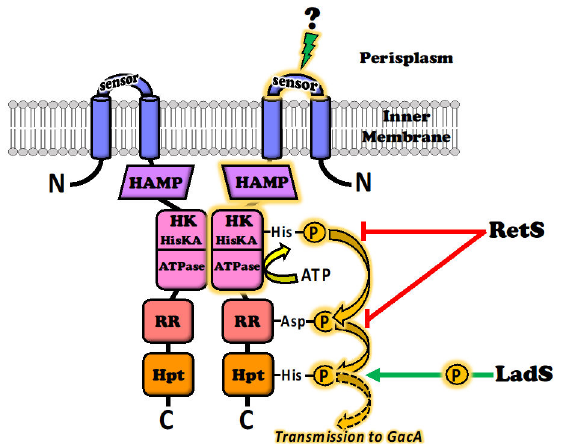
Figure 1. Architecture and functioning of the GacS sensor kinase. GacS is capable of collecting a pool of membrane stimuli: the central environmental source signal (still unknown) is perceived by the periplasmic sensor domain and causes a conformational change that is mechanically transmitted by the HAMP domain to the histidine kinase (HK) domain, leading to autophosphorylation of the key histidyl residue. The phosphorelay involves transmission by the response signal receiver (RR) and histidine phosphotransfer (Hpt) domains, to the cytosolic GacA response regulator. The GacS signal route (marked in amber) is modulated by other environmental cues provided by two other membrane kinase sensors: LadS stimulates GacS activity by shuttling additional phosphate groups into the Hpt domain (green arrow), whereas RetS inhibits GacS activity by siphoning phosphates from the GacS HK, dephosphorylating the RR domain, and / or blocking access to the key histidyl residue of the HK domain (red